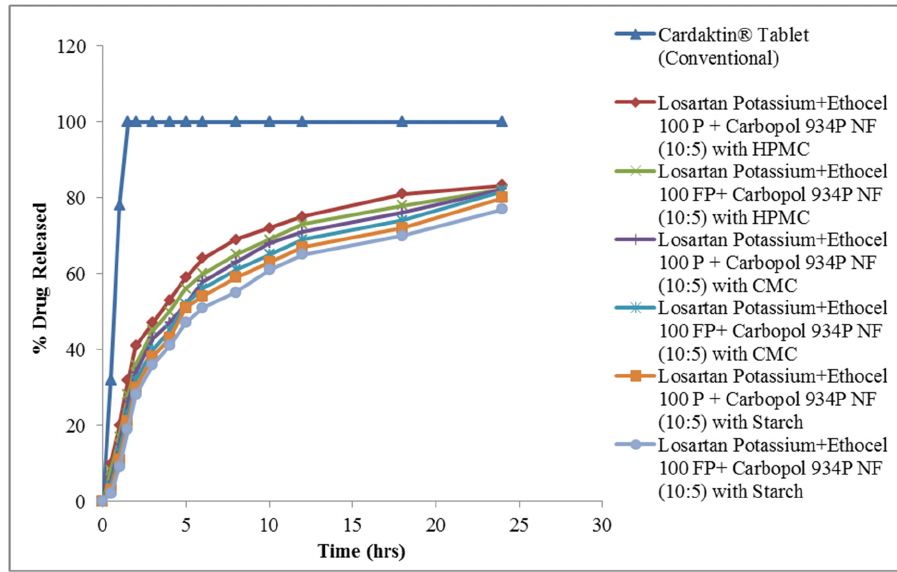
Figure 1. Release patterns of CR matrices of ethocel grade 100 and carbopol P 934 NF.